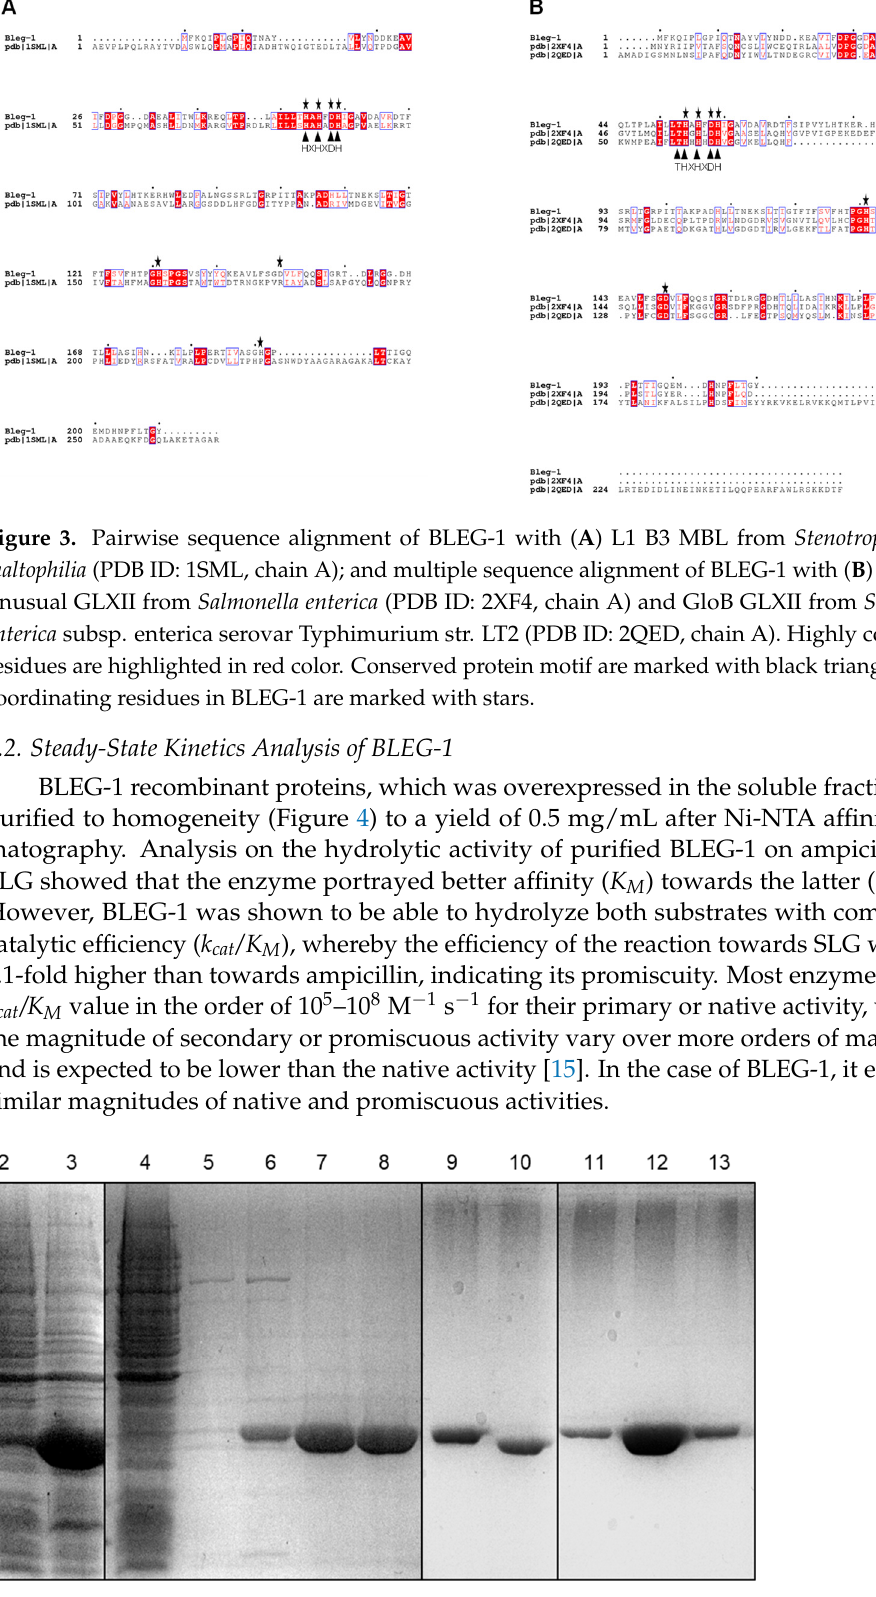
Figure 4. SDS-PAGE (12%) analysis of BLEG-1. Lane 1: unstained protein marker (Thermo Fisher Scientific, Waltham, MA, USA), size range: 14.4-116.0 kDa; lane 2: total cell extract (insoluble fraction); lane 3: total cell extract (soluble fraction); lane 4: HisTrap™ FF flow-through; lane 5 to 8: HisTrap™ FF elution fractions; lane 9: His-tagged BLEG-1; lane 10: thrombin-treated BLEG-1; lane 11 to 13: Q-Sepharose™ FF elution fractions. Molecular weight of BLEG-1 with and without His-tag are 26 and 23 kDa,